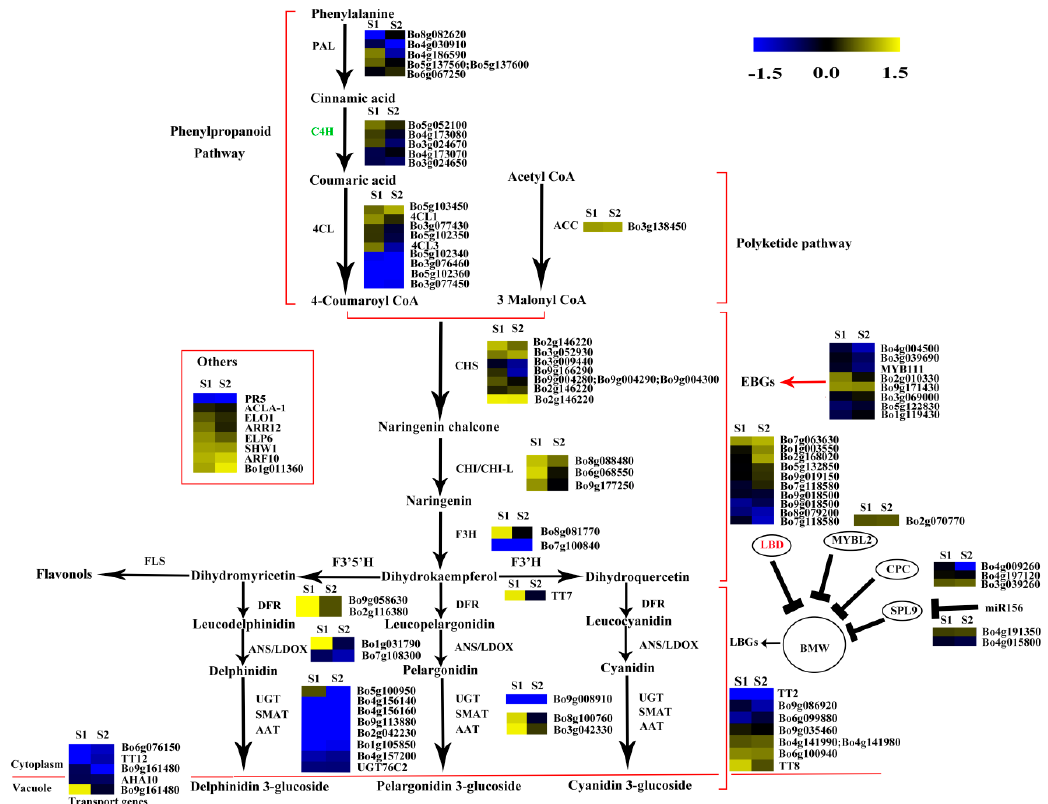
Figure 8. Expression patterns of the genes involved in anthocyanin biosynthesis in S2 vs. S1. Enzyme names in red represent upregulated genes in S2 vs. S1. Enzyme names in green represent downregulated genes in S2 vs. S1. The red parentheses represent the four pathways, the black and red arrows represent the positive regulation and black “ T ” represent negative regulation. The genes in the red box are the other genes involved in anthocyanin biosynthesis.